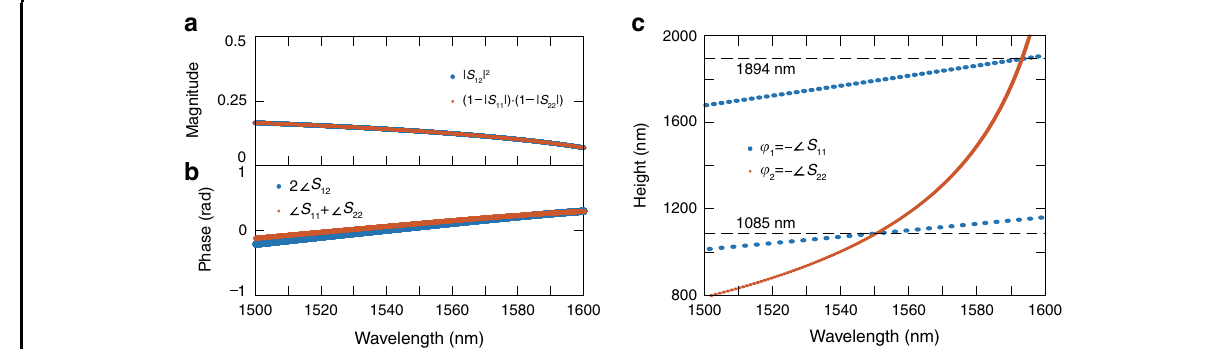
Fig. 4 Phase conditions for BICs. a , b Magnitude and phase for the BIC condition. They are automatically satis fi ed for lossless/reciprocal networks containing at least two modes. c Conditions for half round-trip propagation phases of the two different modes. They are only satis fi ed at discrete points due to dispersion. BICs occur at the intersection of the two curves, which are guaranteed for discrete sets of pillar heights and effective